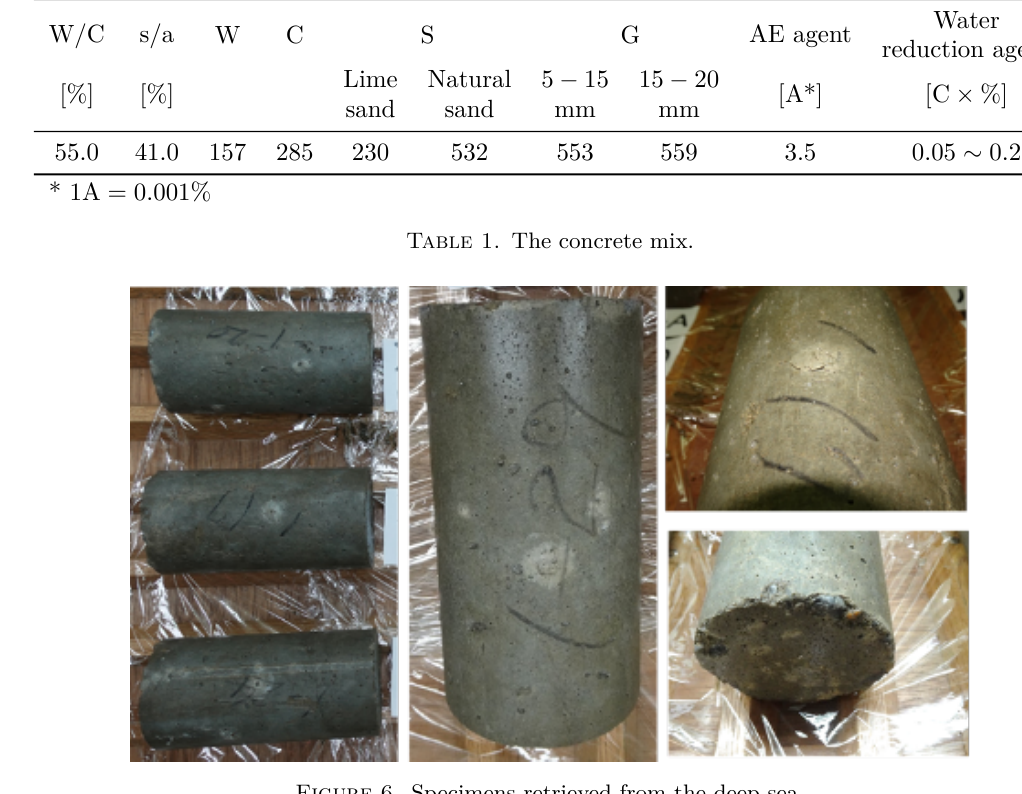
Figure 6. Specimens retrieved from the deep sea.